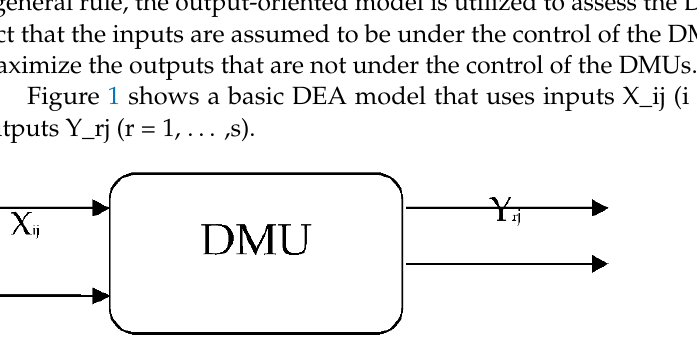
Figure 1. An example of the DEA. In cases where there are negative values in the data, special DEA models should be used, one of the most common of which is the SBM (slack-based measure) model, which is shown in the objective function of model